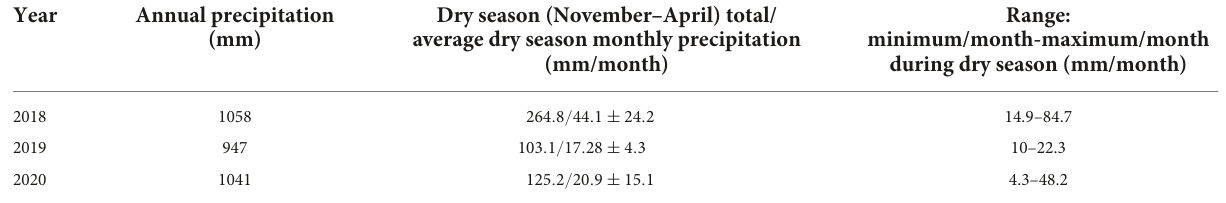
TABLE 1 Precipitation patterns in Tooxi, Yanhuitlán, Oaxaca from 2018 to